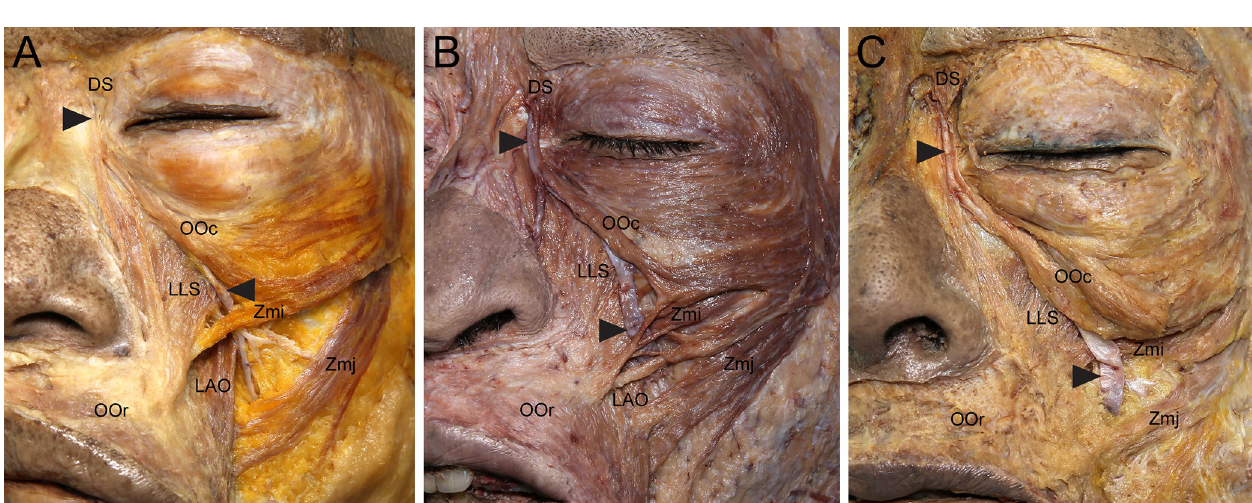
PLOS ONE | https://doi.org/10.1371/journal.pone.0276121 October 13,